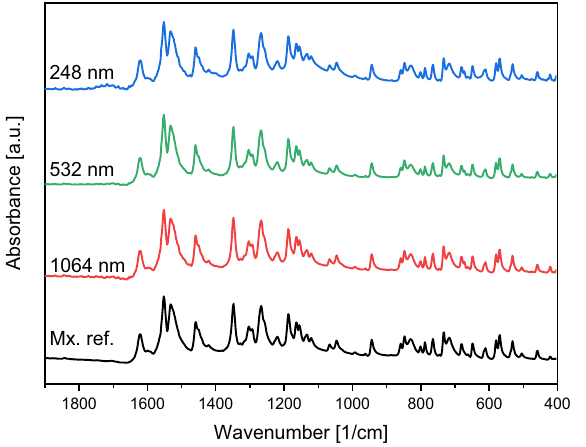
Figure 3. Fingerprint region of the FTIR spectra of the particles prepared by PLAL at different wavelengths (248 nm, 532 nm, 1064 nm) and the meloxicam (Mx. ref.). All spectra were normalized to the peak at ~ 1550 cm −1 .